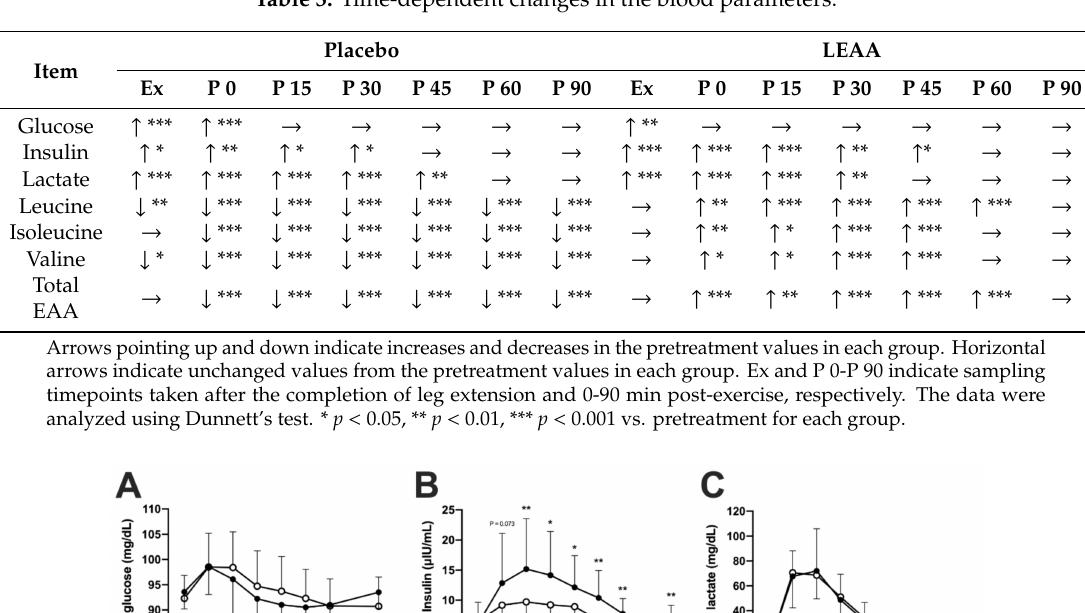
Table 3. Time-dependent changes in the blood parameters.